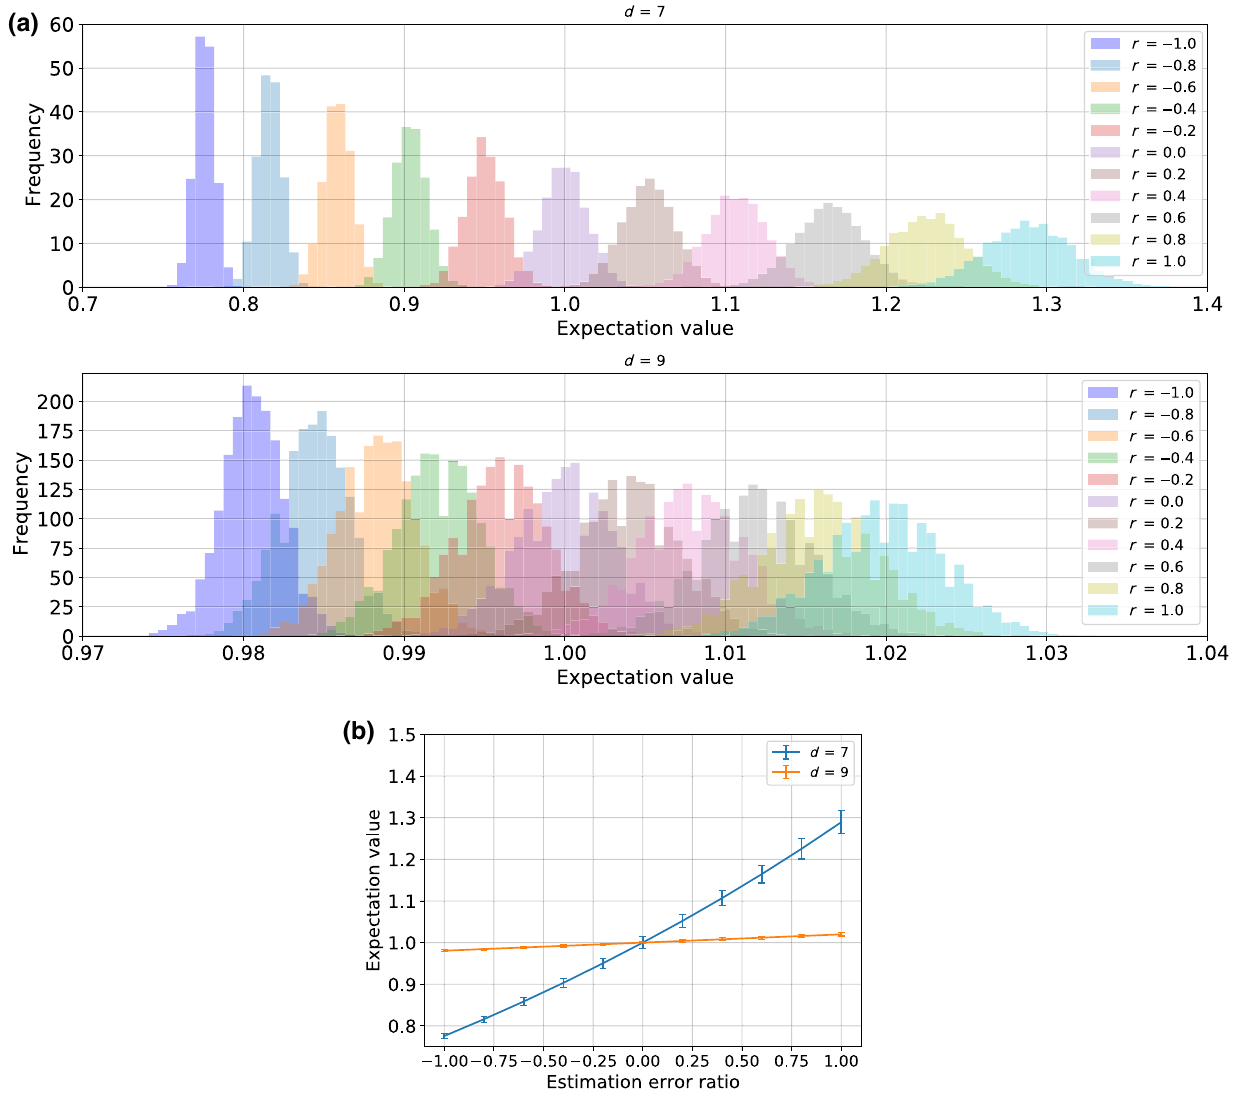
FIG. 9. Histogram of expectation values with estimation errors. (a) Histogram of expectation values. (b) Sample averages and standard deviation as a function of estimation